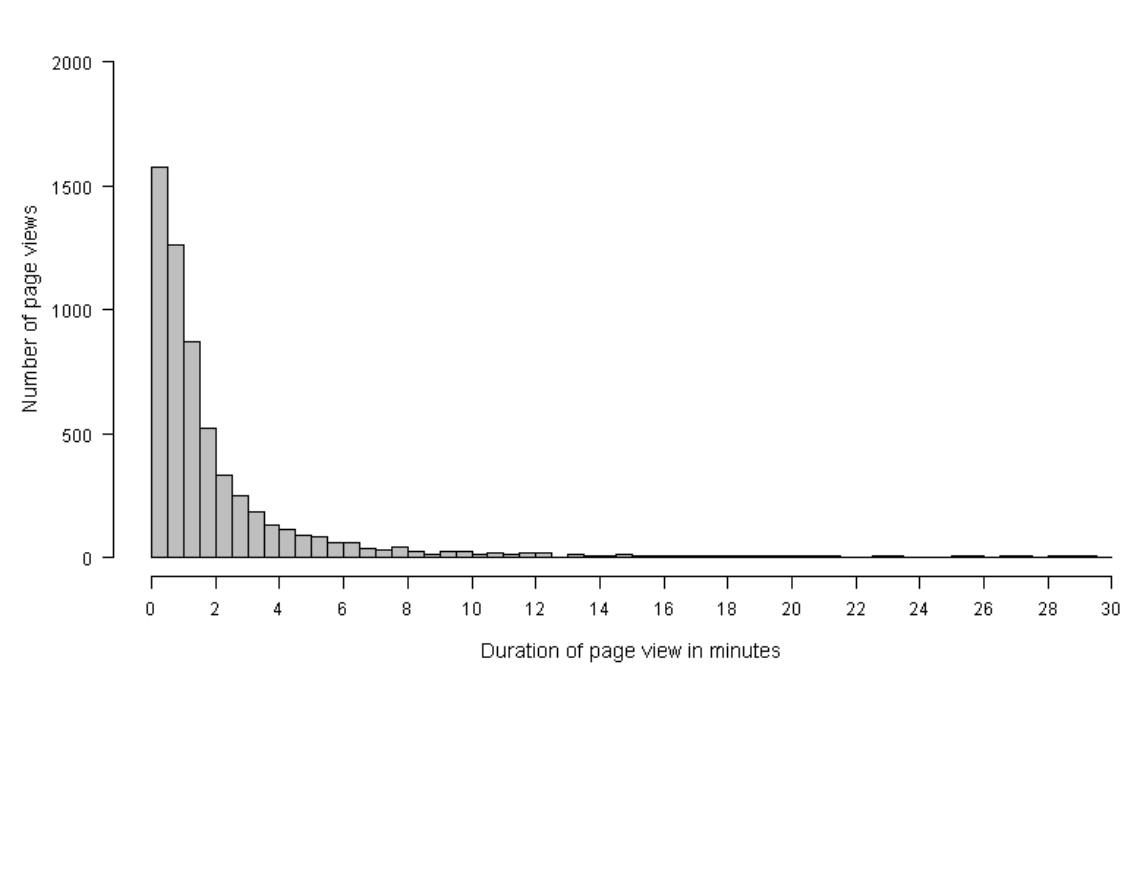
Figure 1. Distribution of minutes spent viewing an intervention page, excluding page views that resulted in an automatic